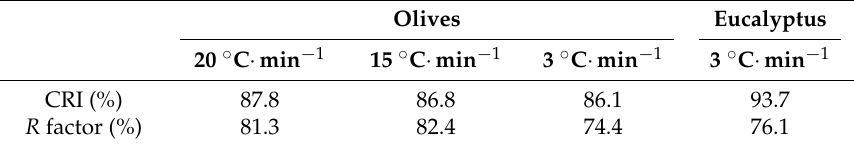
Table 11. Reactivity results of pyrolysis bioreducers (750 ˝ C) (30 g and 750 mL ¨ min ´ 1 CO 2